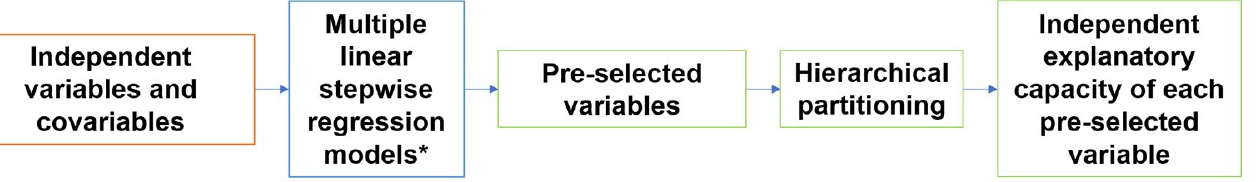
Figure 3. Schematic representation of hierarchical partitioning analysis applied to each of the 11 dependent variables (HRV indices). The pre-selected variables were distinctive for each of the 11 HRV indices. * A multiple linear stepwise regression model was applied for each category of independent variables and covariables as described in Figure 2.